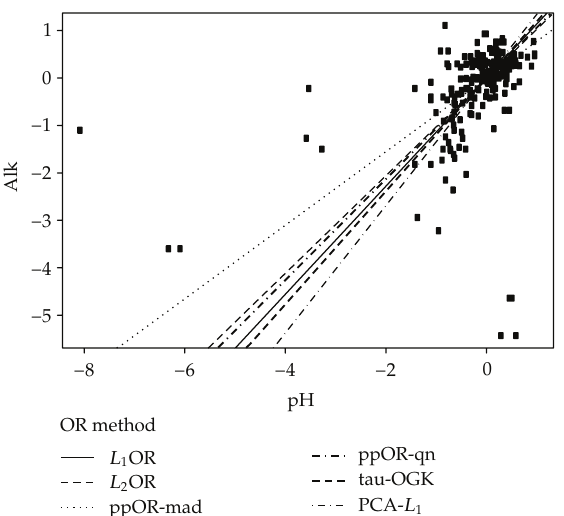
Figure 5: Scatter plot of pH versus alkalinity with models from L 1 OR, L 2 OR, and ppOR-mad; ppOR-qn, τ -OGK, and PCA- L 1